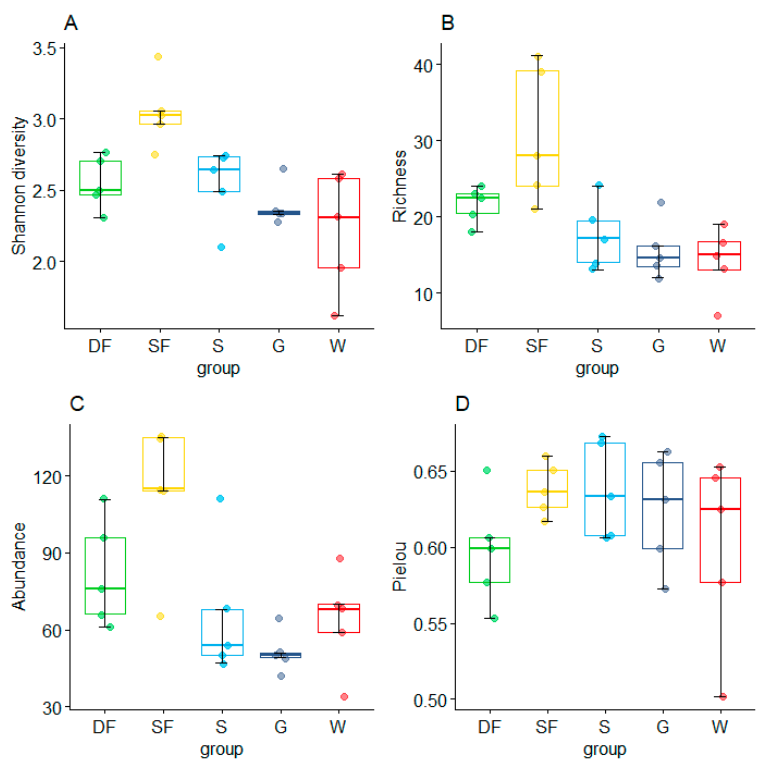
Figure 6. Comparison of bird diversity ( A ), richness ( B ), abundance ( C ), and Pielou index ( D ) in five vegetation habitats in urban mountain parks in Fuzhou, China. DF, dense forest; SF, sparse forest; S, shrub; G, grassland; W, Waterfront.